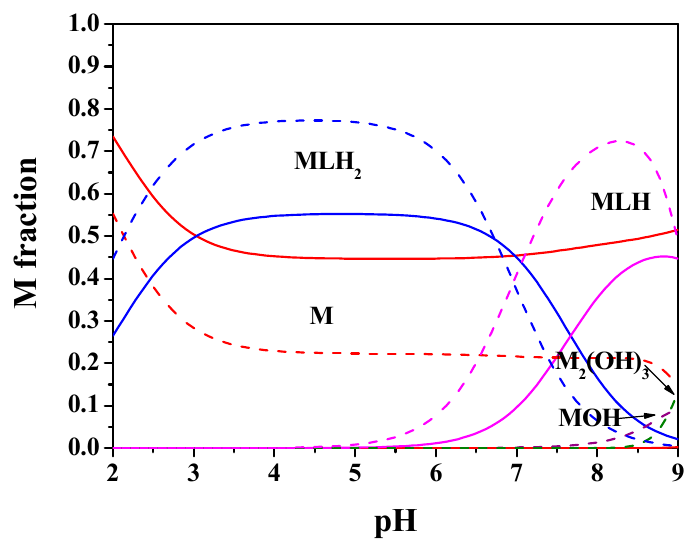
Figure 10. Speciation diagram of Mn 2+ - Amox (L) system, at C M = 2 mmol L − 1 , C L = 4 mmol L − 1 , I = 0.15 mol L − 1 , t = 15 °C (solid line), t = 37 °C (dashed line).